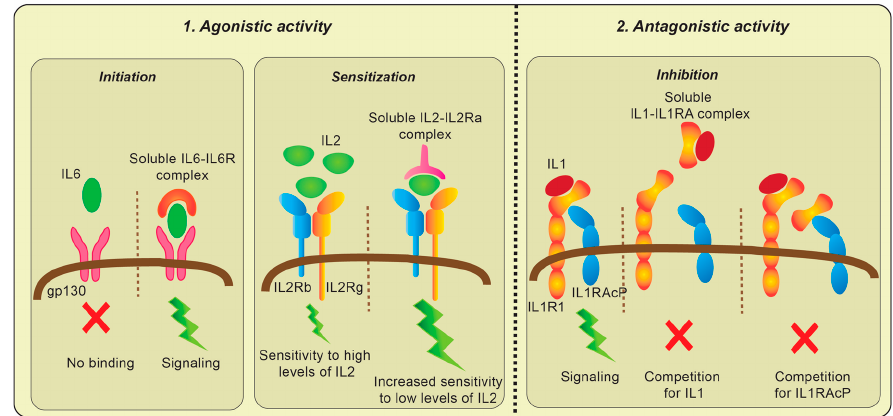
Figure 1. Mechanisms of action by soluble receptors and ligand–receptor complexes. Schematic representation of the mechanisms by which soluble receptors and ligand–receptor complexes influence membrane-bound receptor components and regulate signal transduction and cellular activity.